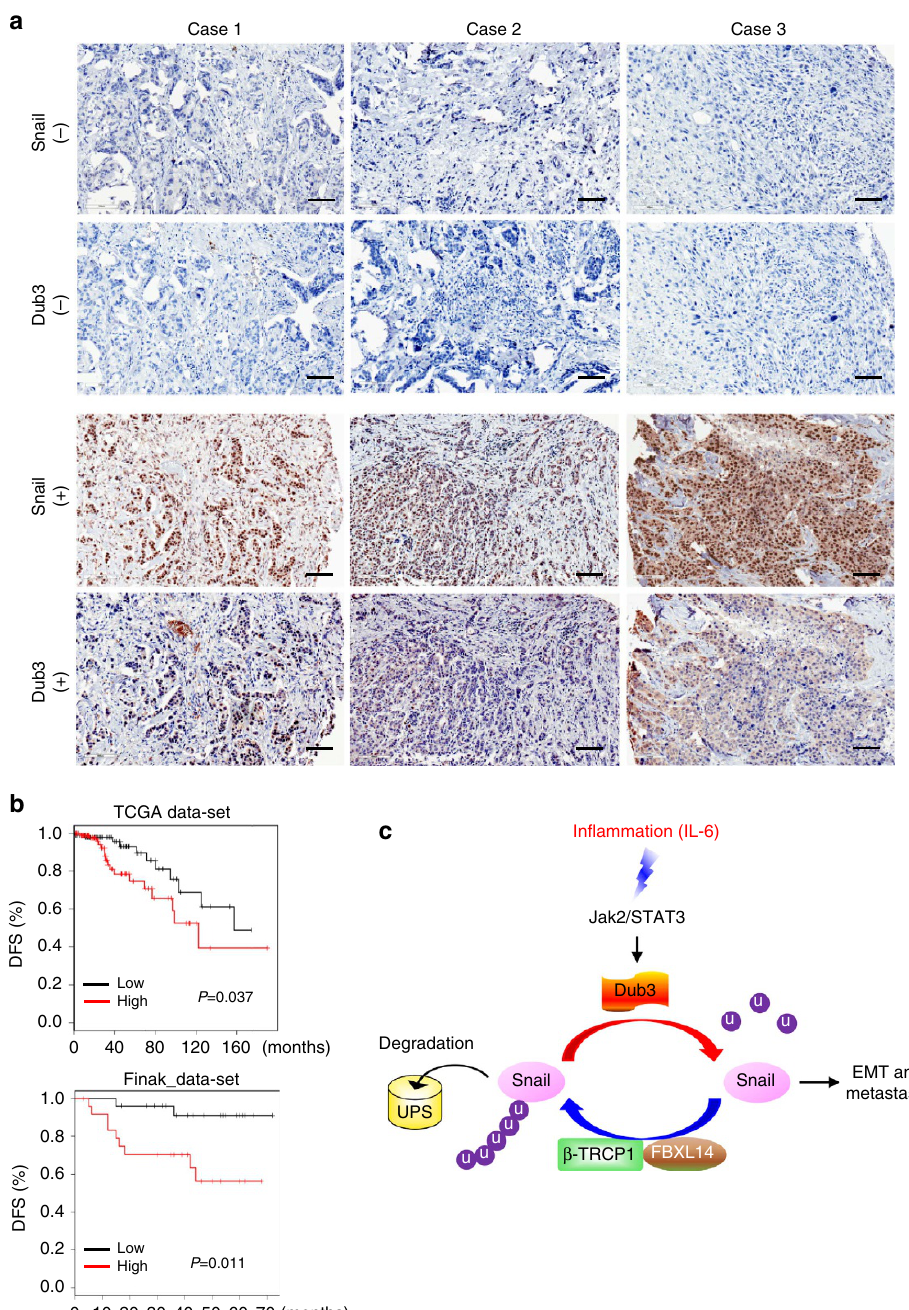
Figure 8 | Expression of Dub3 and Snail1 are positively correlated in breast cancer patients. ( a ) The 334 surgical specimens of breast cancer were immunostained using antibodies against Dub3, Snail1, and the control serum (data not shown). Images with consecutive IHC staining of both Dub3 and Snail1 in six cases of breast tumours (top panel: three cases of negative staining; bottom panel: three cases of positive) are shown (Scale bars, 50 m m). Statistical analysis is shown Tables 1–3. ( b ) Kaplan–Meier plots of distant metastasis-free survival of patients, stratified by expression of Dub3. Data obtained from the TCGA and Finak database. P -values represent log-rank testing of the difference in cumulative survival. ( c ) A proposed model to illustrate Dub3 induces Snail1 stabilization through a deubiquitination event. IL-6 induces the expression of Dub3, which antagonizes the function Snail1’s ubiquitin E3 ligase (such as FBXL14 and b -TRCP1), leading to Snail1 stabilization and the acquisition of EMT and